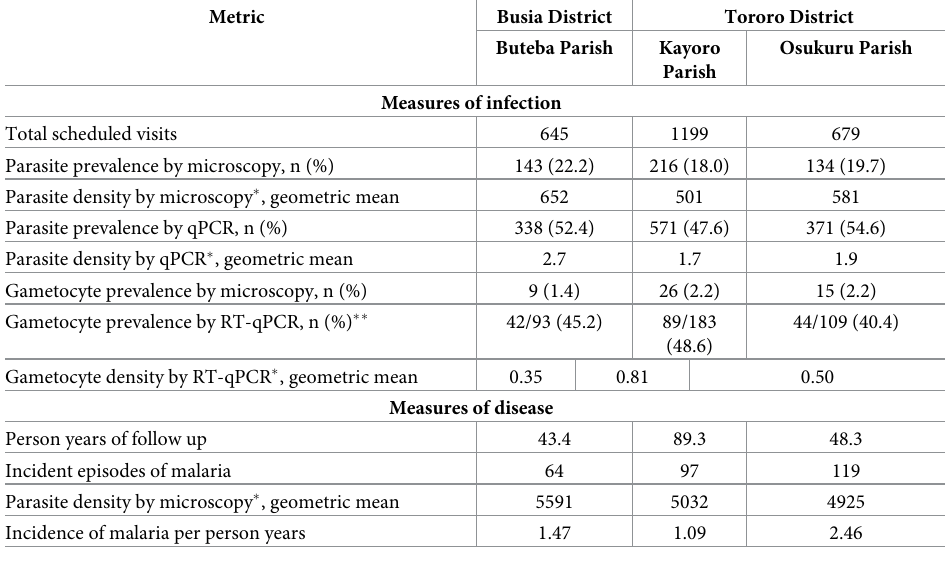
Table 3. Measures of infection and disease stratified by